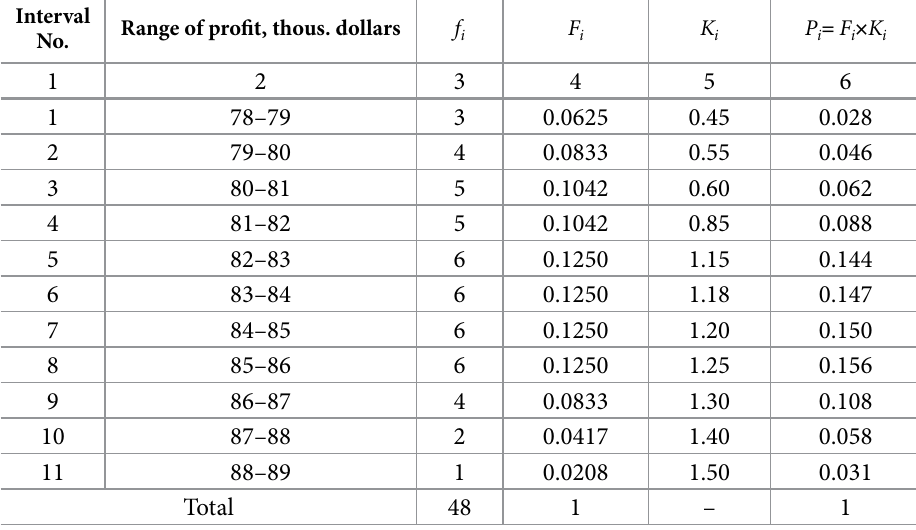
Table 4. Calculation of probability Interval Range of profit, thous. No.